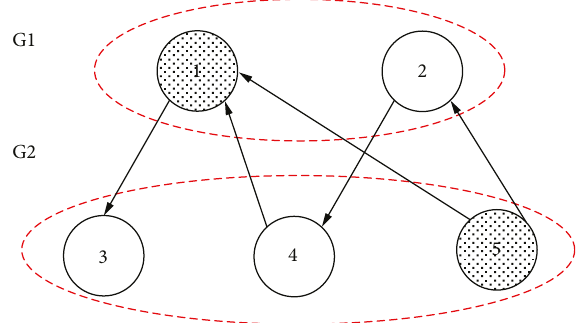
Figure 6: The directed bipartite